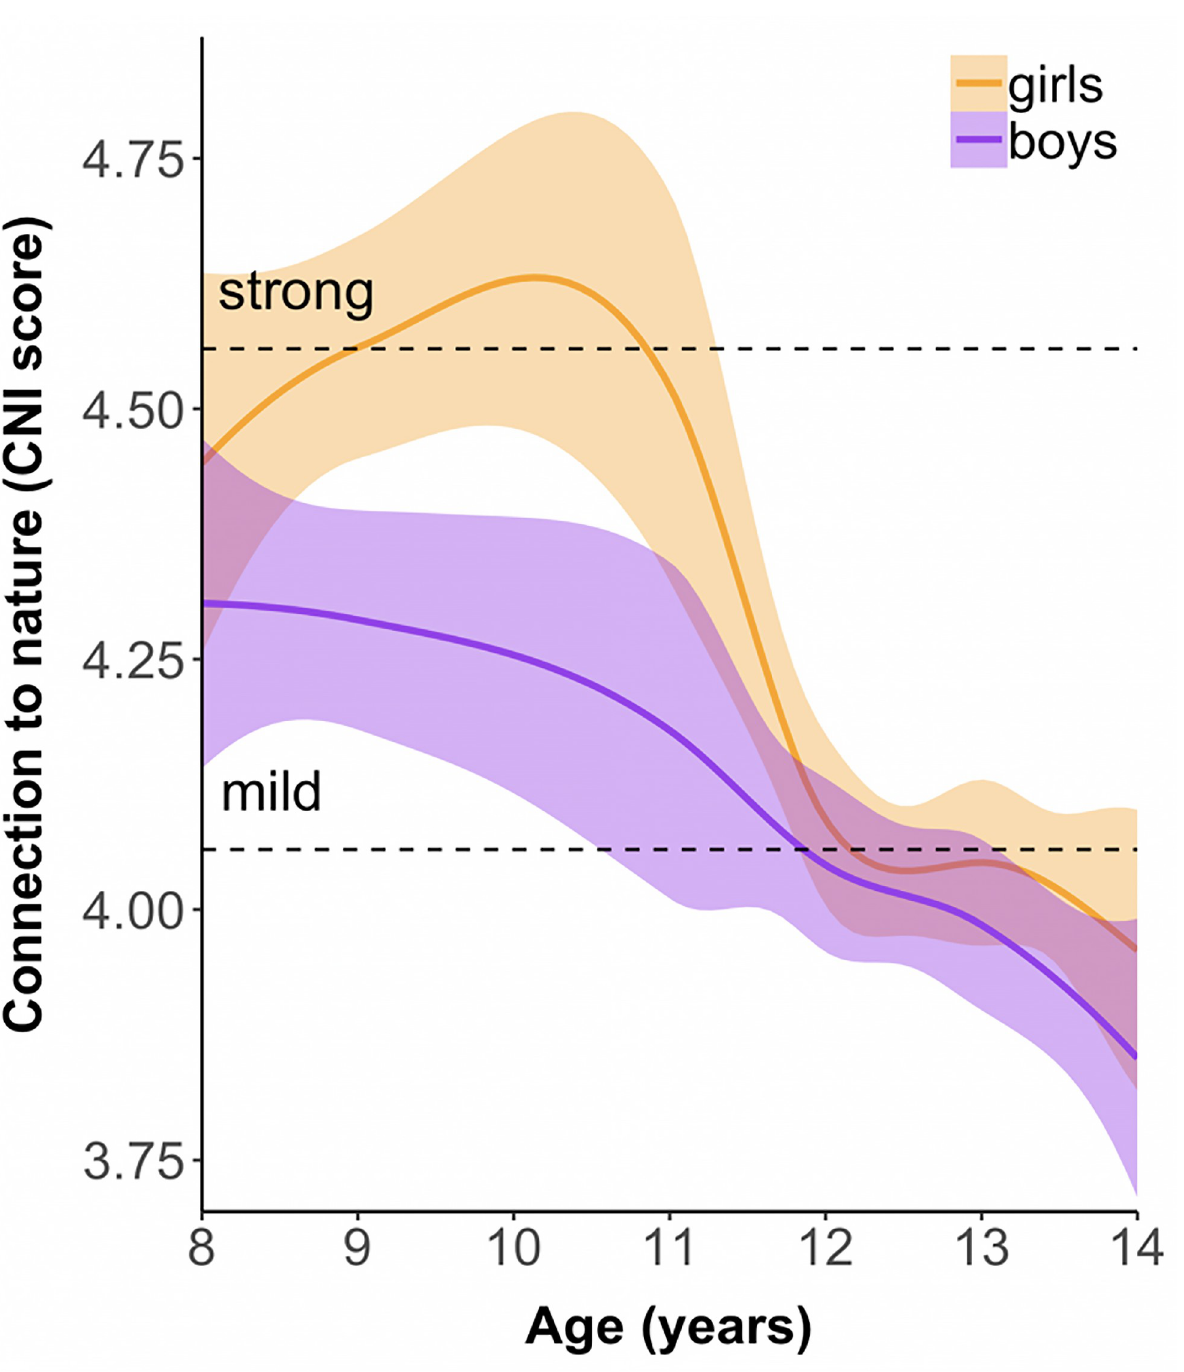
Fig 1. Connection to nature across middle childhood and adolescent years. Trend lines are smoothed Loess curves showing conditional means with 95% CI shaded. N = 1,037 (569 girls and 468 boys); see S1 Table for a breakdown by age.